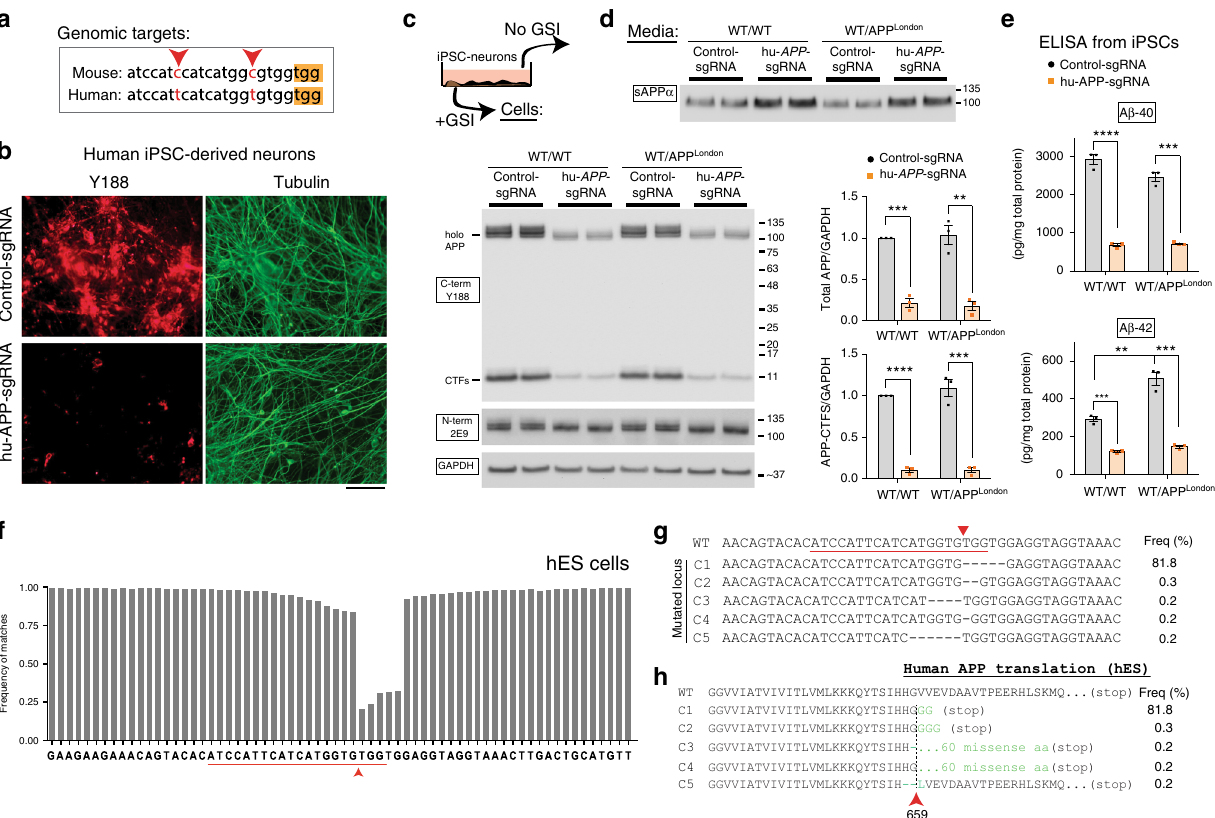
Fig. 2 Gene editing of APP C-terminus and effects on APP processing in human cells. a Comparison of mouse and human APP -sgRNA targeting sequences (red arrowheads indicate differences; yellow bar denotes the PAM site). b Human iPSC-derived NPCs were transduced by lentiviral vectors carrying hu- APP -sgRNA and Cas9 (or non-targeting control-sgRNA/Cas9 as control) and differentiated into neurons. After 3 weeks of differentiation, cells were immunostained with the Y188 and Tuj1 (tubulin) antibodies. Note decreased APP (Y188) fl uorescence, indicating APP editing. Scale bar 50 μ m. c The iPSC- derived neurons above (or isogenic APPV717I London-mutant knock-in iPSC-neurons) were transduced and differentiated as above and immunoblotted with C- and N-terminus antibodies (GSI was added to allow detection of accumulated APP CTFs). Note attenuation of APP signal with Y188 after hu- APP - sgRNA treatment in both wild type and isogenic APP London iPSCs (quanti fi ed on right, mean ± SEM of three independent experiments). d Media from the iPSC-derived neurons above was immunoblotted for secreted sAPP α (6E10 antibody). Note increased sAPP α in sgRNA-treated samples, indicating upregulation of the non-amyloidogenic pathway. e ELISA of media from iPSC derived neurons. Note decreased A β in the sgRNA-treated samples (mean ± SEM of three independent experiments). f Deep sequencing of APP C-terminus in human ESCs. Red underline marks the sgRNA target sequence and arrowhead denotes predicted cut-site. Note extensive mismatch around predicted cut-site, indicating robust editing. g Major mutated APP -loci resulting from CRISPR editing, and their frequencies. h Predicted APP translational products (post-editing) for the major mutant alleles observed in deep sequencing. Note that after editing, APP is translated up-to amino acid 659 (red arrowheads; similar results were seen in HEK cells, see Supplementary Fig. 1e). For all panels, signi fi cance determined with two-tailed t -test, ** p < 0.01, *** p < 0.001, **** p < 0.0001. Source data are provided as a Source Data fi